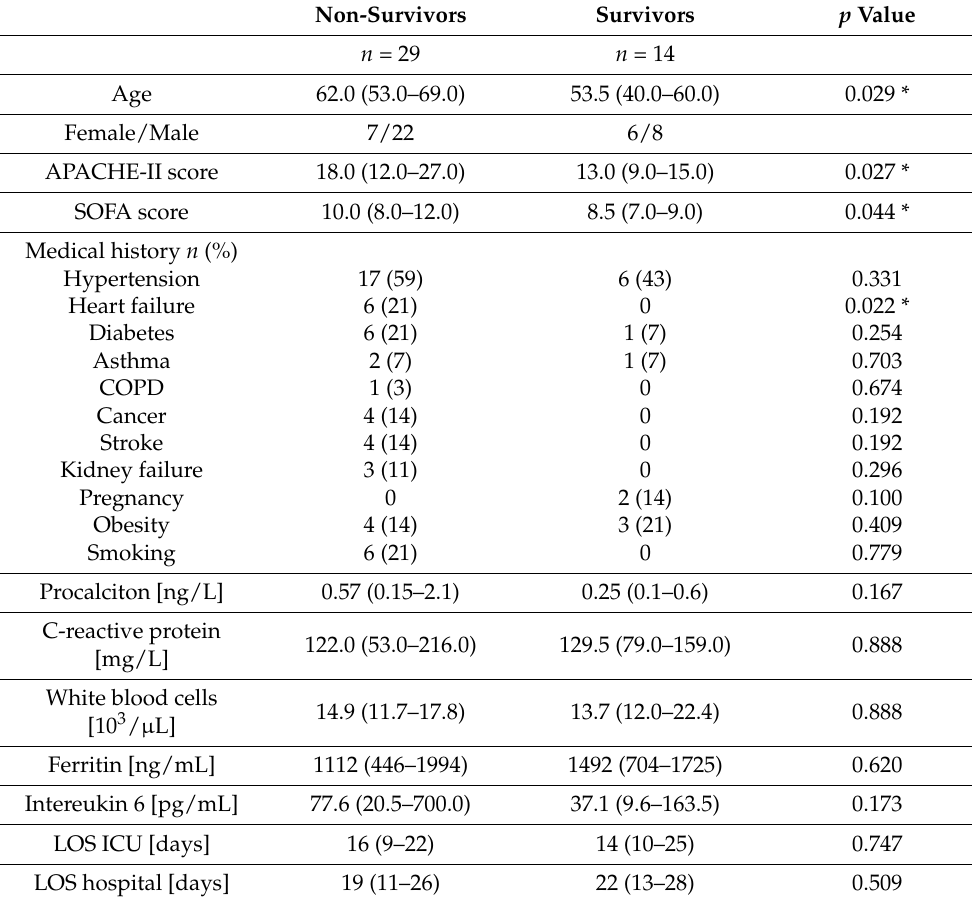
Table 1. Characteristics of patients with a COVID-19 diagnosis on admission to the